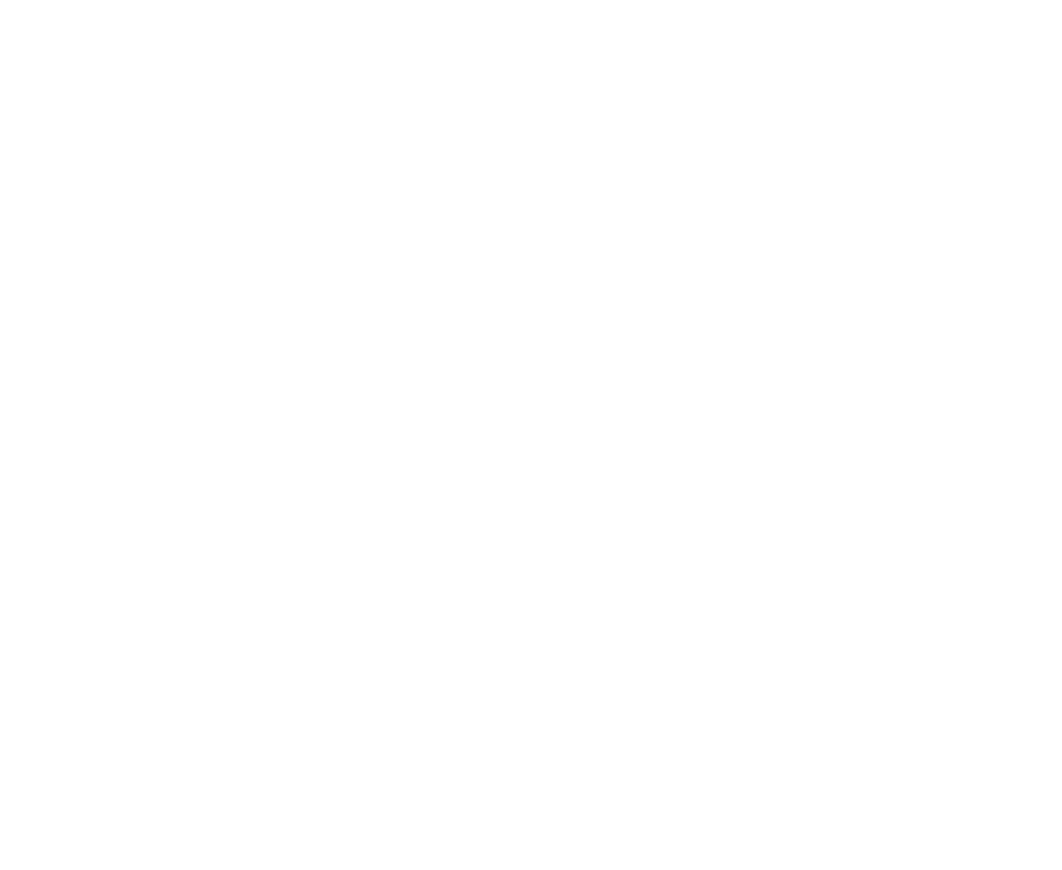
A still image of the RIJV, diameters and cross-sectional